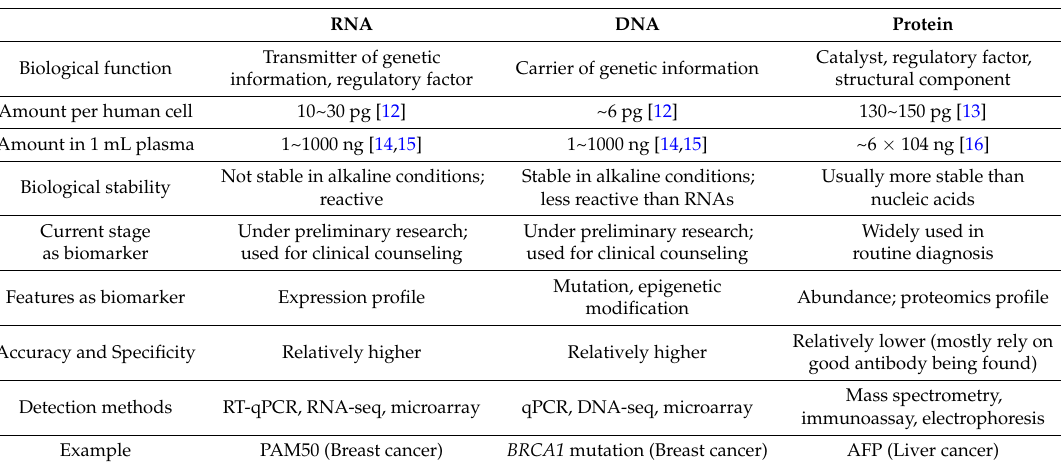
Table 1. Comparison of macromolecular biomarkers. RNA DNA